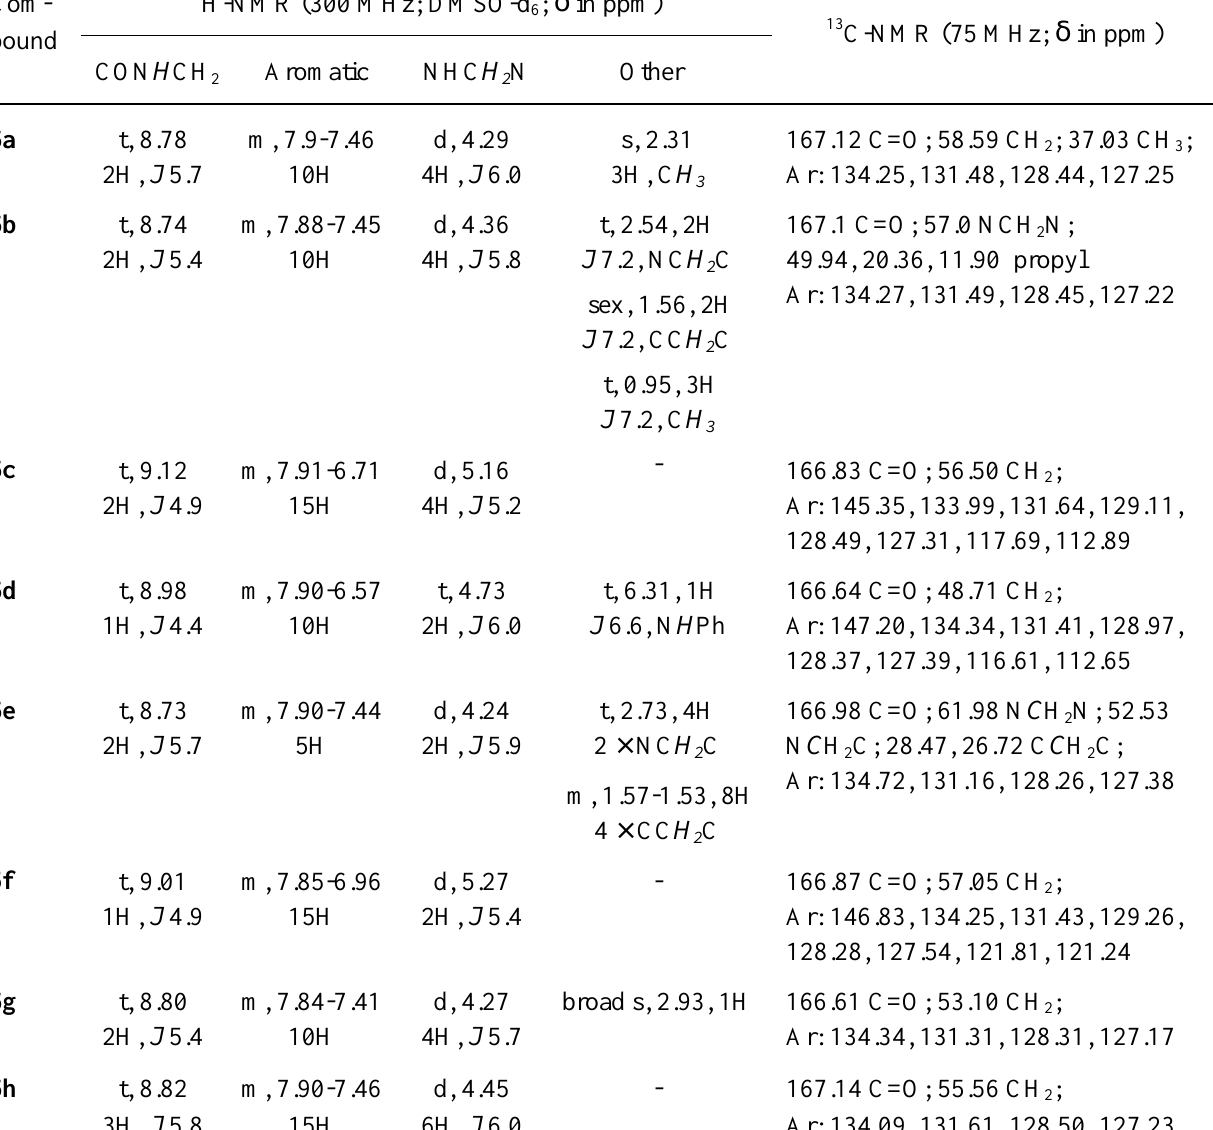
Table 3. NMR data of compounds 5